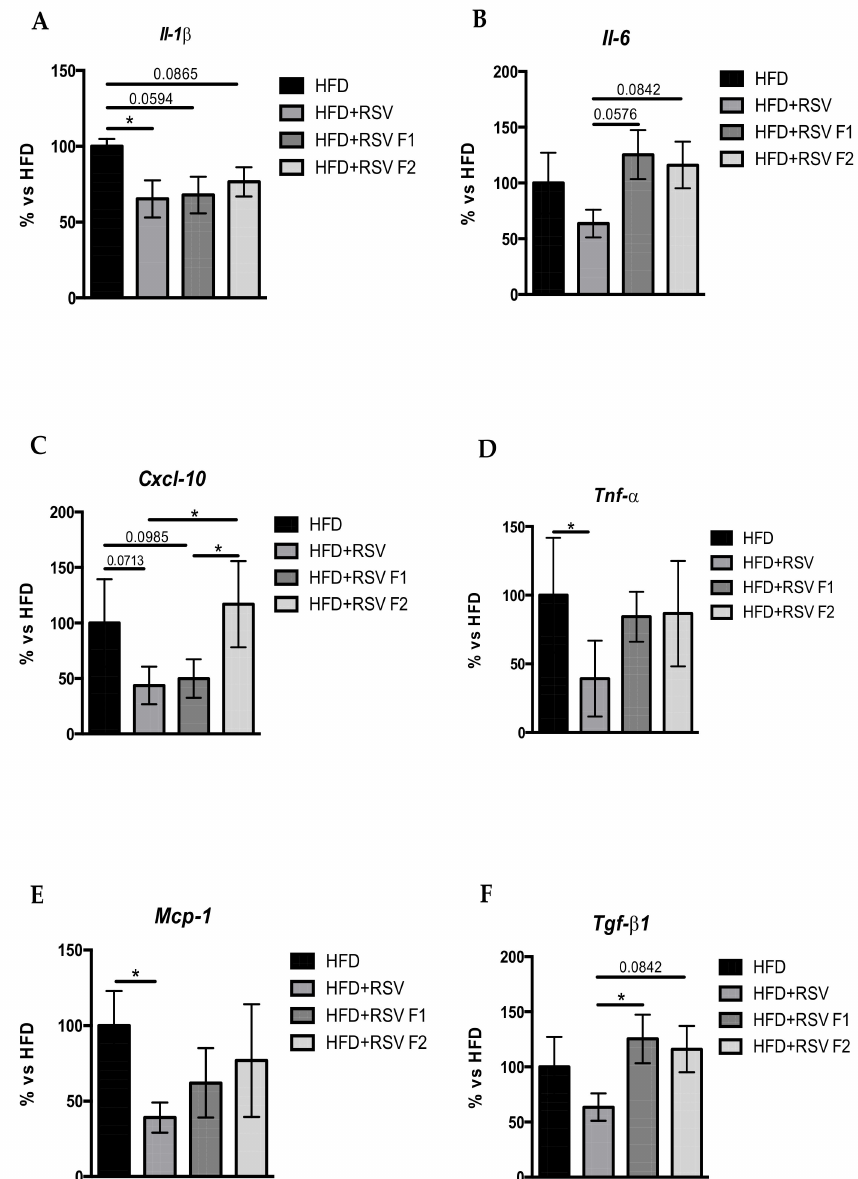
Figure 4. Results of gene expression of inflammatory markers for Il1-ß ( A ), Il-6 ( B ), Cxcl-10 ( C ), Tnf- α ( D ), Mcp-1 ( E ), and Tgf-ß1 ( F ) in the hippocampus of SAMP8 mice at 6 months of age. Gene expression levels were measured by real-time PCR from hippocampal tissue. Gene expression data from each RSV group were compared to the HFD group (set at 100%); n = 16-24 (HFD n = 4-6, HFD + RSV n = 4–6, HFD + RSV F1 n = 4–6, HFD + RSV F2 n = 4–6; for each group, females n = 3–4, males n = 3–4). Statistics: * p <